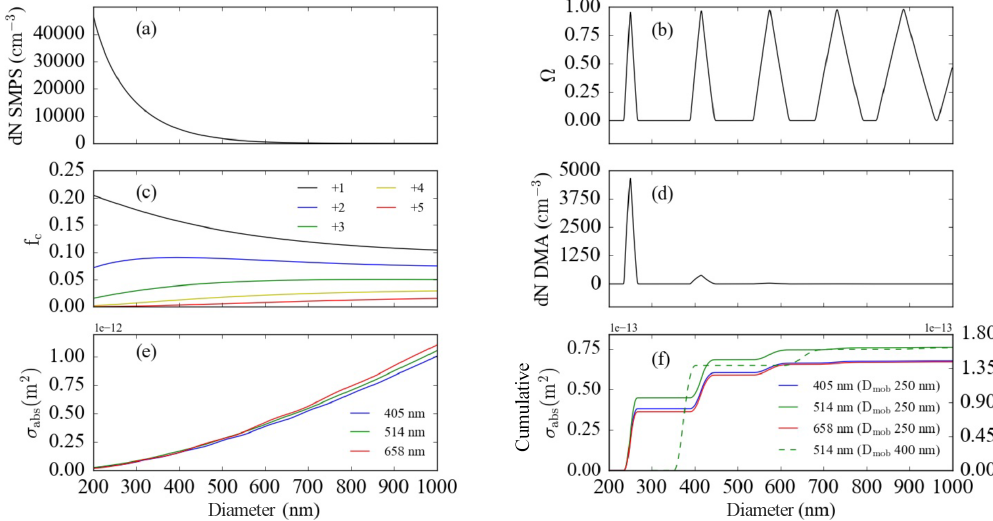
Figure 5. An overview of steps involved in modelling the absorption cross section. (a) SMPS-measured particle size distribution. (b) DMA diffusional transfer function for a fixed DMA voltage corresponding to a mobility-selected diameter of 250nm. (c) Fuch’s charging probabil- ities for positively charged particles. The figure legend indicates the magnitude of the positive charge. (d) Modelled size distribution exiting the DMA column when operated at a fixed voltage for a mobility diameter of 250nm. (e) Absorption cross sections calculated using Mie theory for three visible wavelengths of light, as indicated in the figure legend. (f) Cumulative absorption cross sections for nigrosin with a mobility-selected diameter of 250nm. The dashed green line represents the absorption cross section at wavelength 514nm corresponding to a 400nm mobility-selected diameter nigrosin particle using the scale on the right.